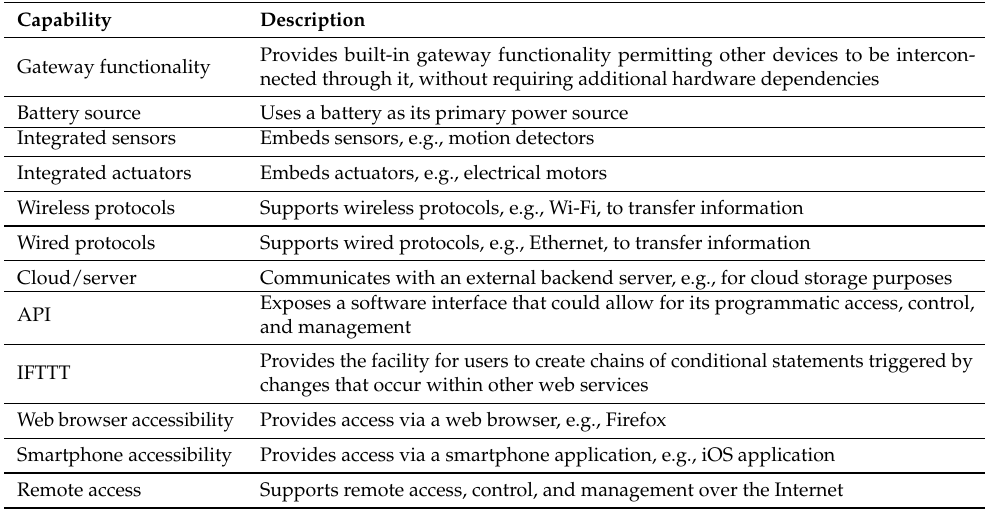
Table 1. An overview of capabilities supported by smart home